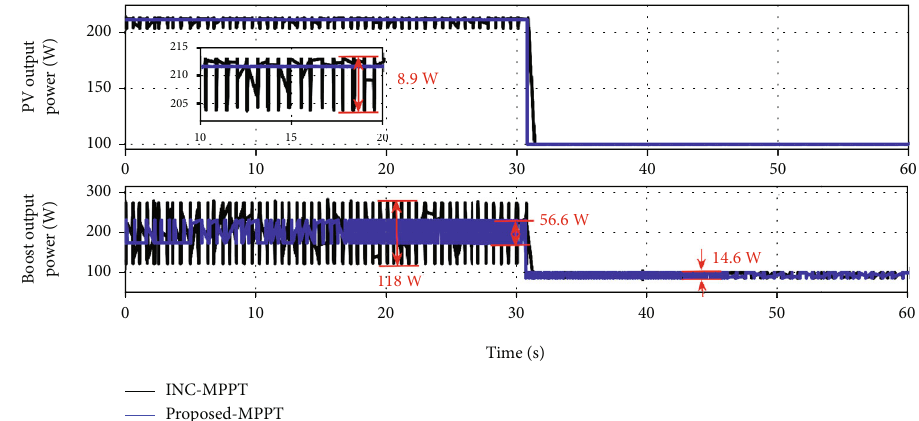
Figure 29: RT-LAB real-time results of the PV array and TLBC output power waveforms of both MPPT schemes under the sudden change of insolation.